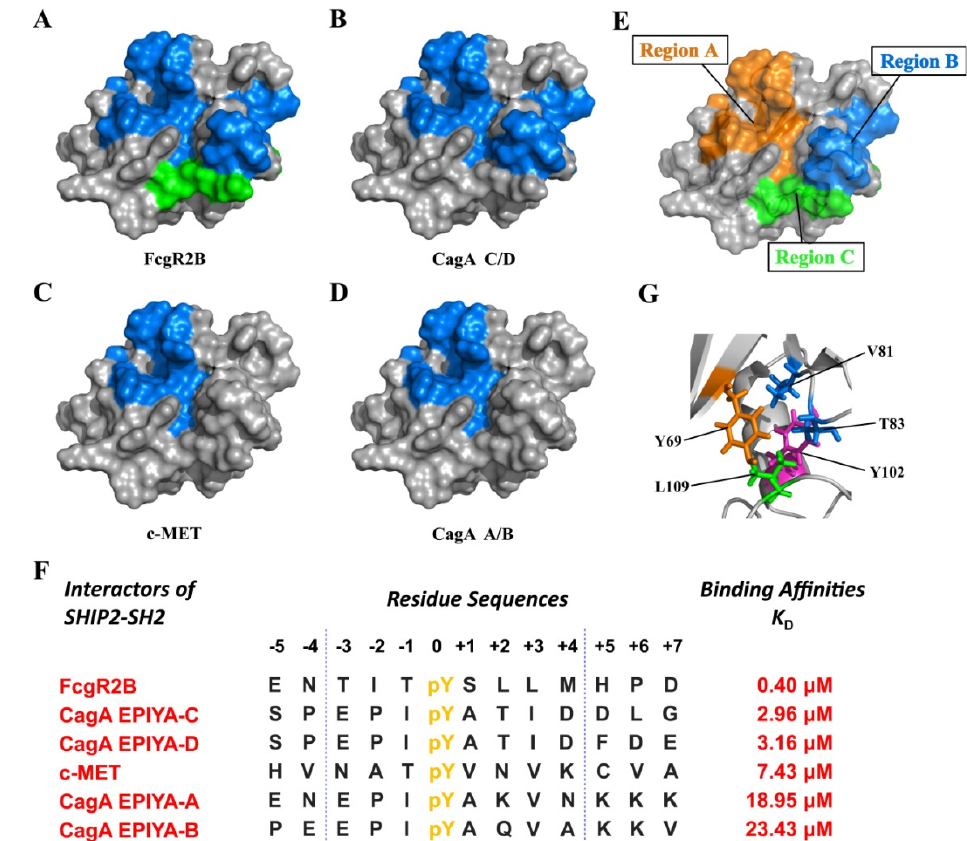
Figure 6. The binding interface and affinity of SHIP2-SH2 for different native ligands. The binding interface of SHIP2-SH2 for FcgR2B ITIM ( A ), CagA EPIYA-C/D ( B ), c-MET C-terminus ( C ), CagA EPIYA-A/B ( D ) is colored in blue. The additional interface of SHIP2-SH2 for 13-mer FcgR2B ITIM compared to 8-mer FcgR2B ITIM is colored in green. The interface was drawn according to the residues of SHIP2-SH2 showing a CSP greater than 0.2 ppm in NMR titration experiments with respective ligand. ( E ) The summarized three regions of SHIP2-SH2 which are differently engaged for binding different ligands are highlighted. ( F ) The summarized sequences and affinities of different SHIP2-SH2 ligands. ( G ) The potential pocket of SHIP2-SH2 for the pY+3 residue in ligand. Potential residues for interacting with the pY+3 residue are shown with sticks and labeled in color, similar to ( E ). Y102 at bottom of the pocket is colored in magenta.